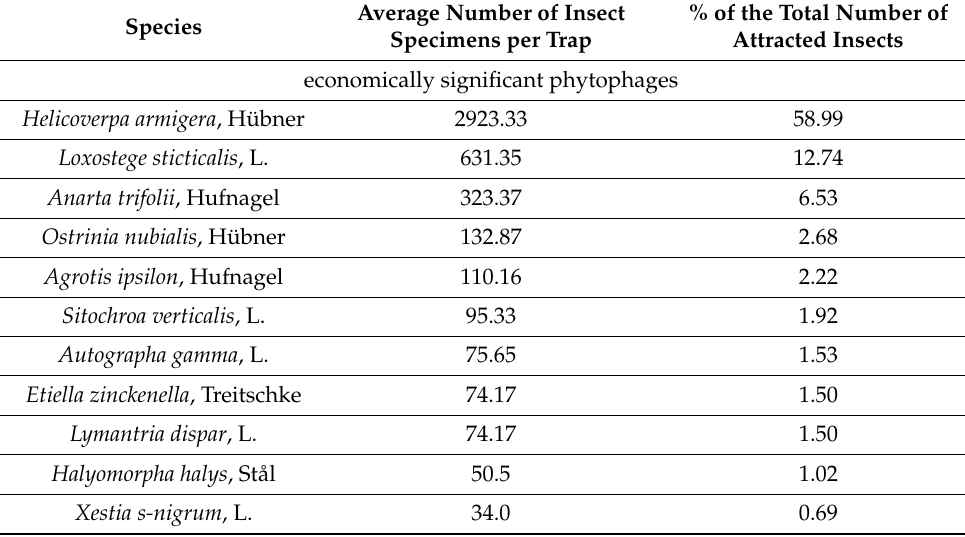
Table 1. Arthropod species attracted by the light trap in amounts of more than 10 specimens during the research period. Central zone of Krasnodar Krai.